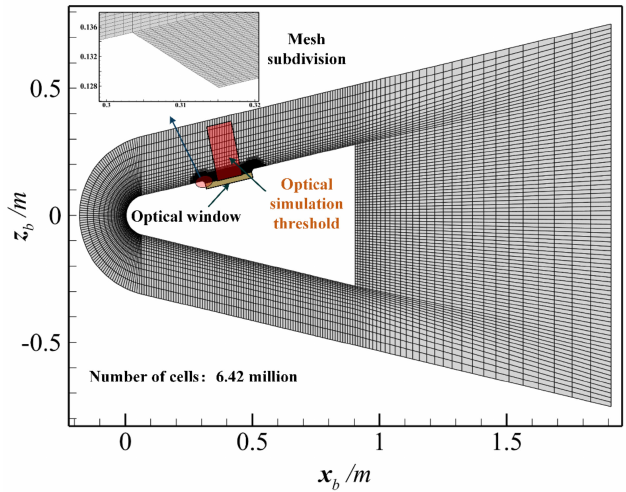
Figure 7. Grid distribution around the hypersonic vehicle and the optical window.